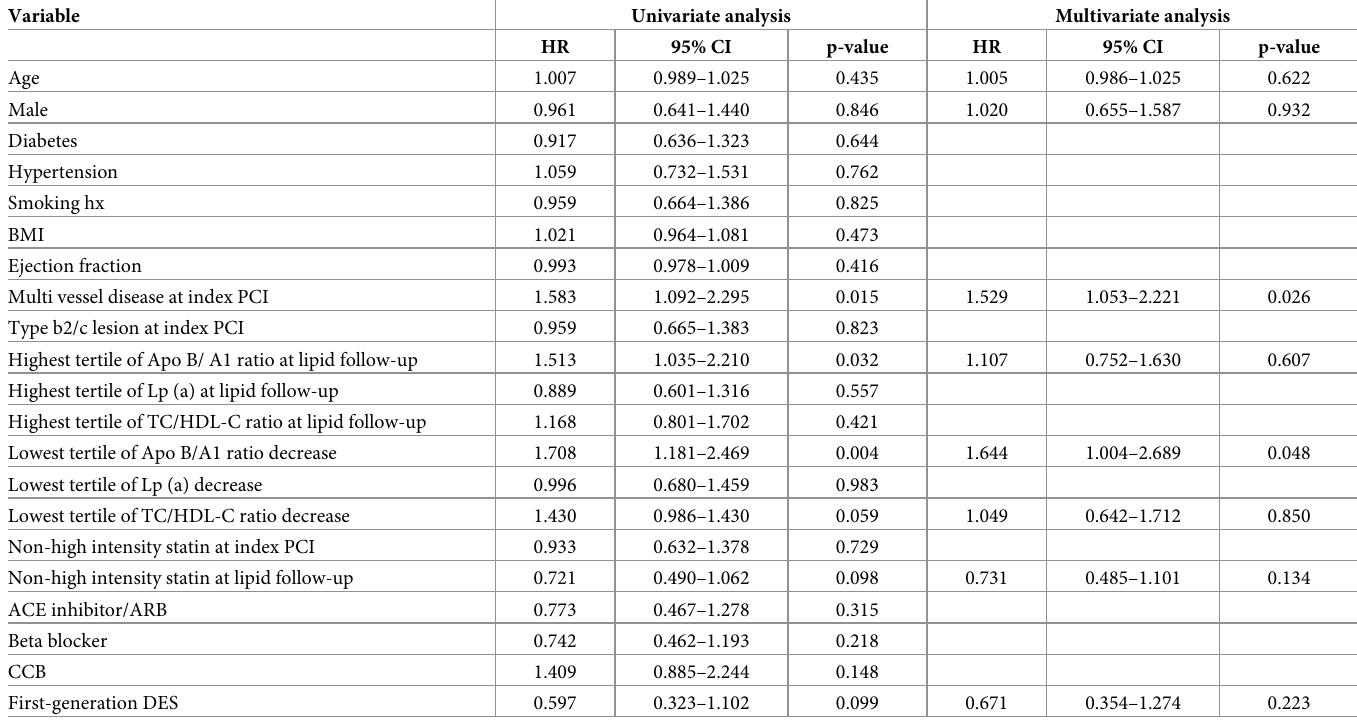
Table 3. Independent predictors for MACEs.